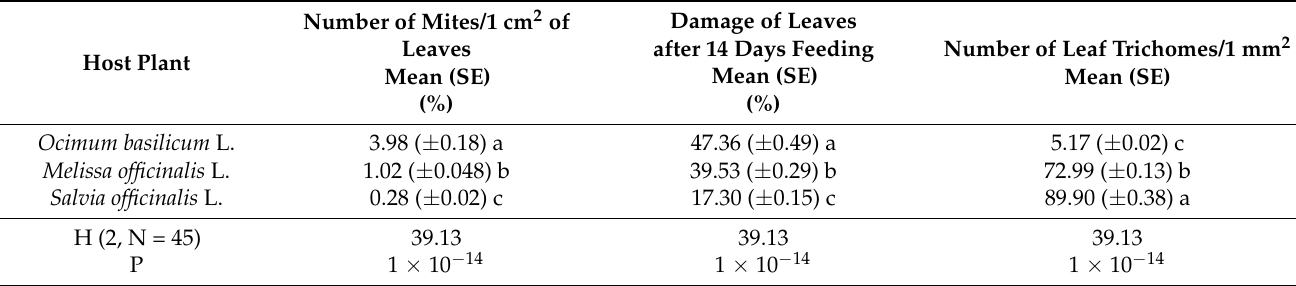
Table 1. The level of acceptance of medicinal plants by Tetranychus urticae and morphological characteristics of plants leaves with percent of leaves damages caused by mite feeding. Damage of Leaves Number of Mites/1 cm 2 of after 14 Days Feeding Leaves Number of Leaf Trichomes/1 mm 2 Host Plant Mean (SE) Mean (SE) Mean (SE) (%) (%) Ocimum basilicum L. 5.17 ( ± 0.02) c Melissa officinalis L. Salvia officinalis L. 1 × 10 − 14 Values in the same column marked by different letters indicate statistically significant differences at p ≤ 0.01 (Kruskal–Wallis’